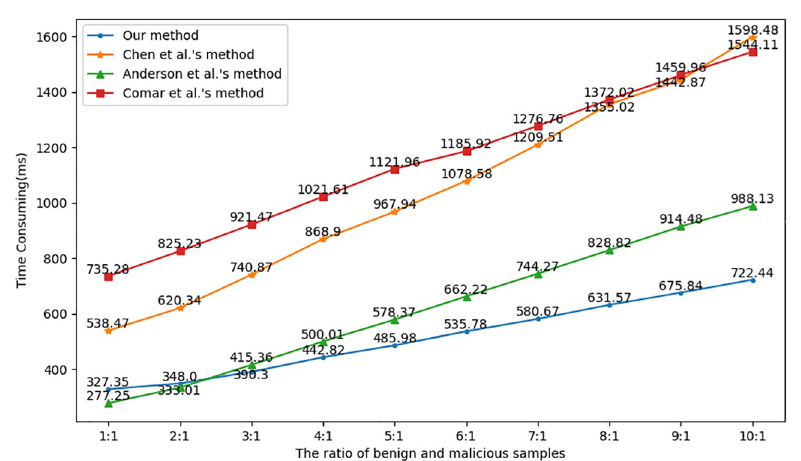
Fig 10. Time consumption among the 4 different